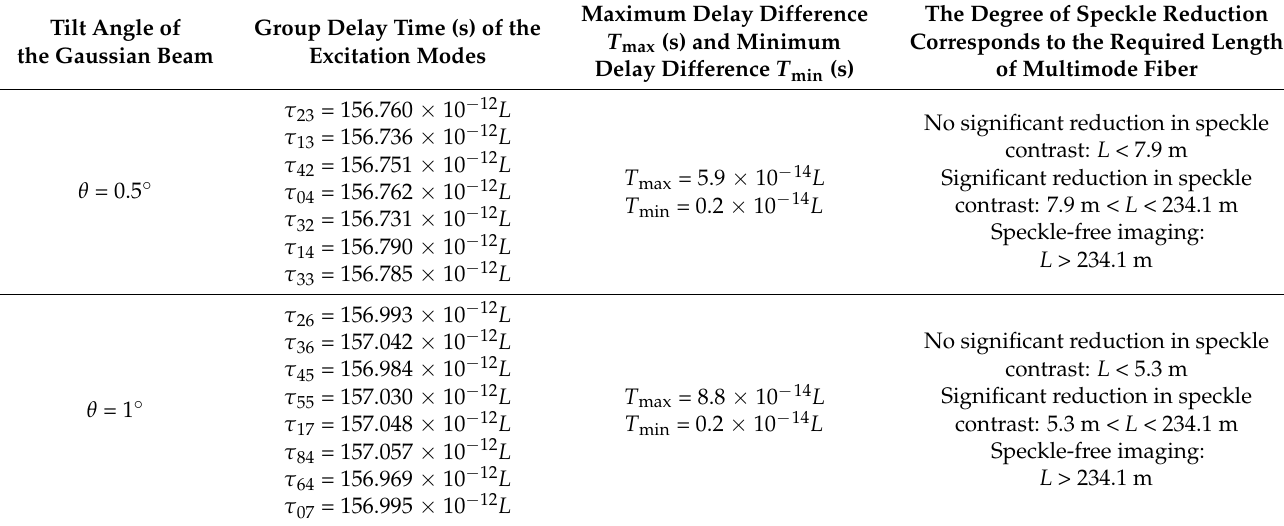
Table 2. The group delay time of excitation modes and the required length of the multimode fiber when the tilt angle of the Gaussian beam is θ = 0.5 ◦ and θ = 1 ◦ , respectively. Tilt Angle of the Gaussian